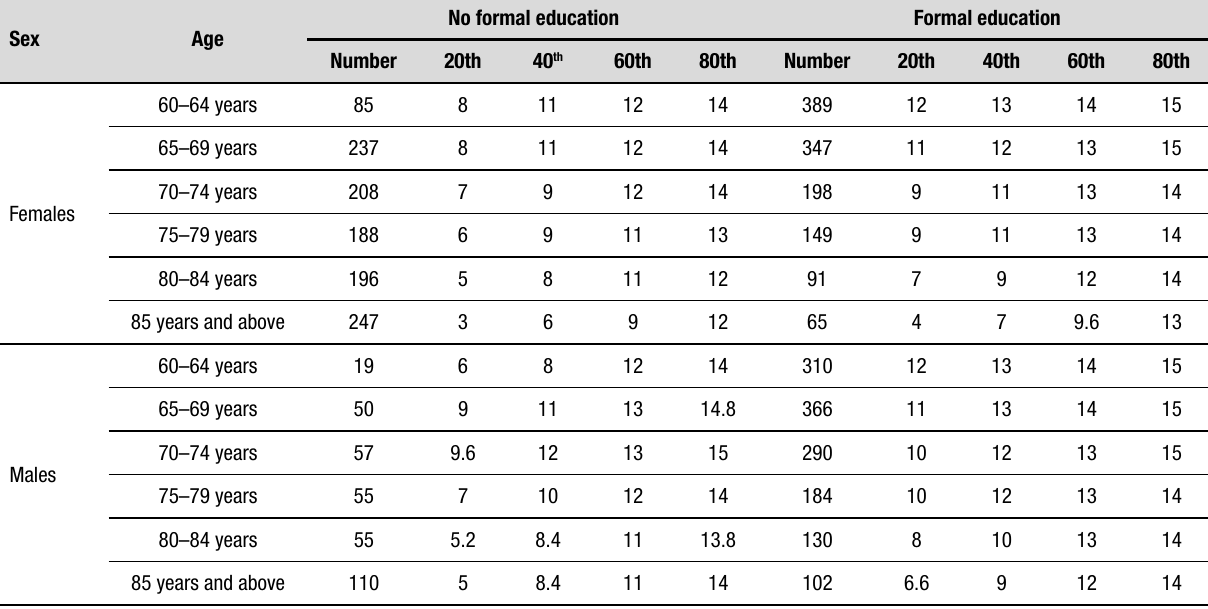
Table 2. Quintiles for the total Identification of Dementia in Elderly Africans cognitive screen score by the combined categories of age, sex, and education. No formal education Formal education Sex Age Number 20th 40 th 60th